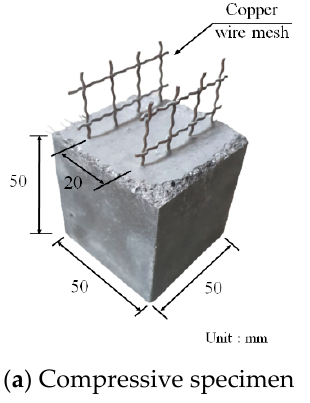
Figure 7. Designs of the sensing specimens.